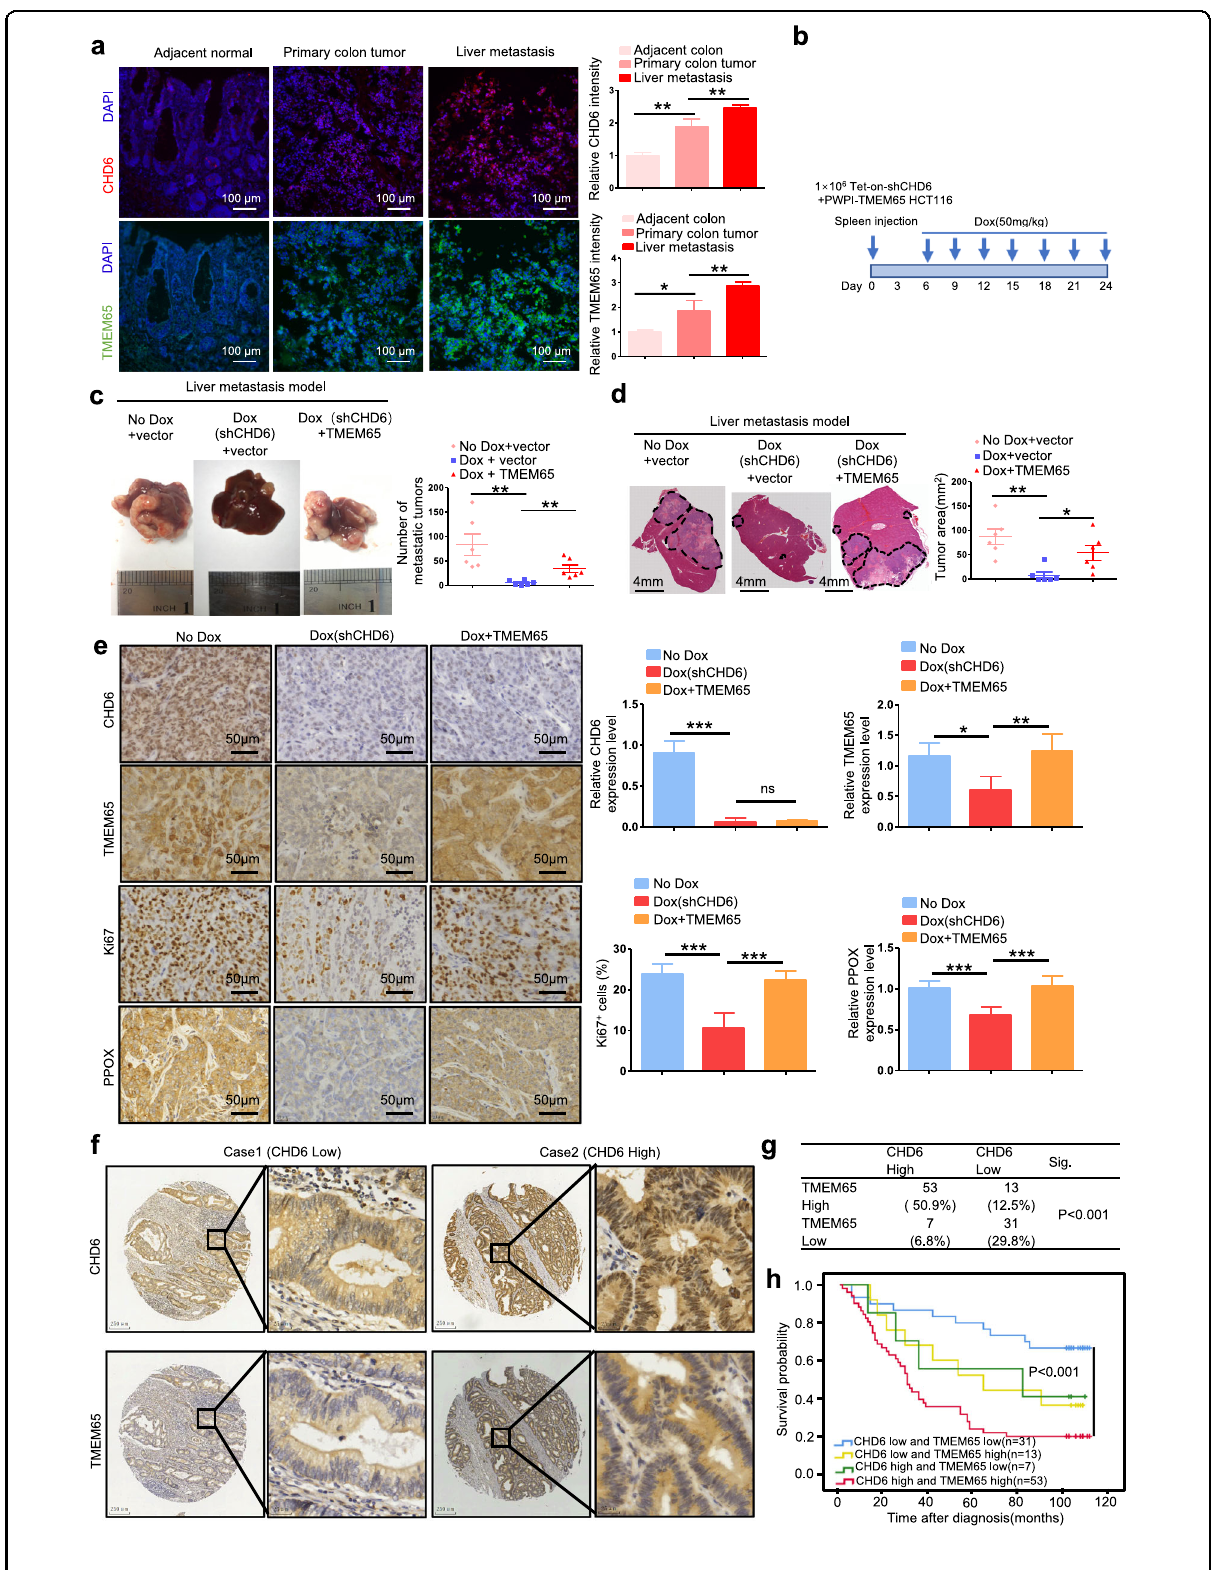
Fig. 6 (See legend on next